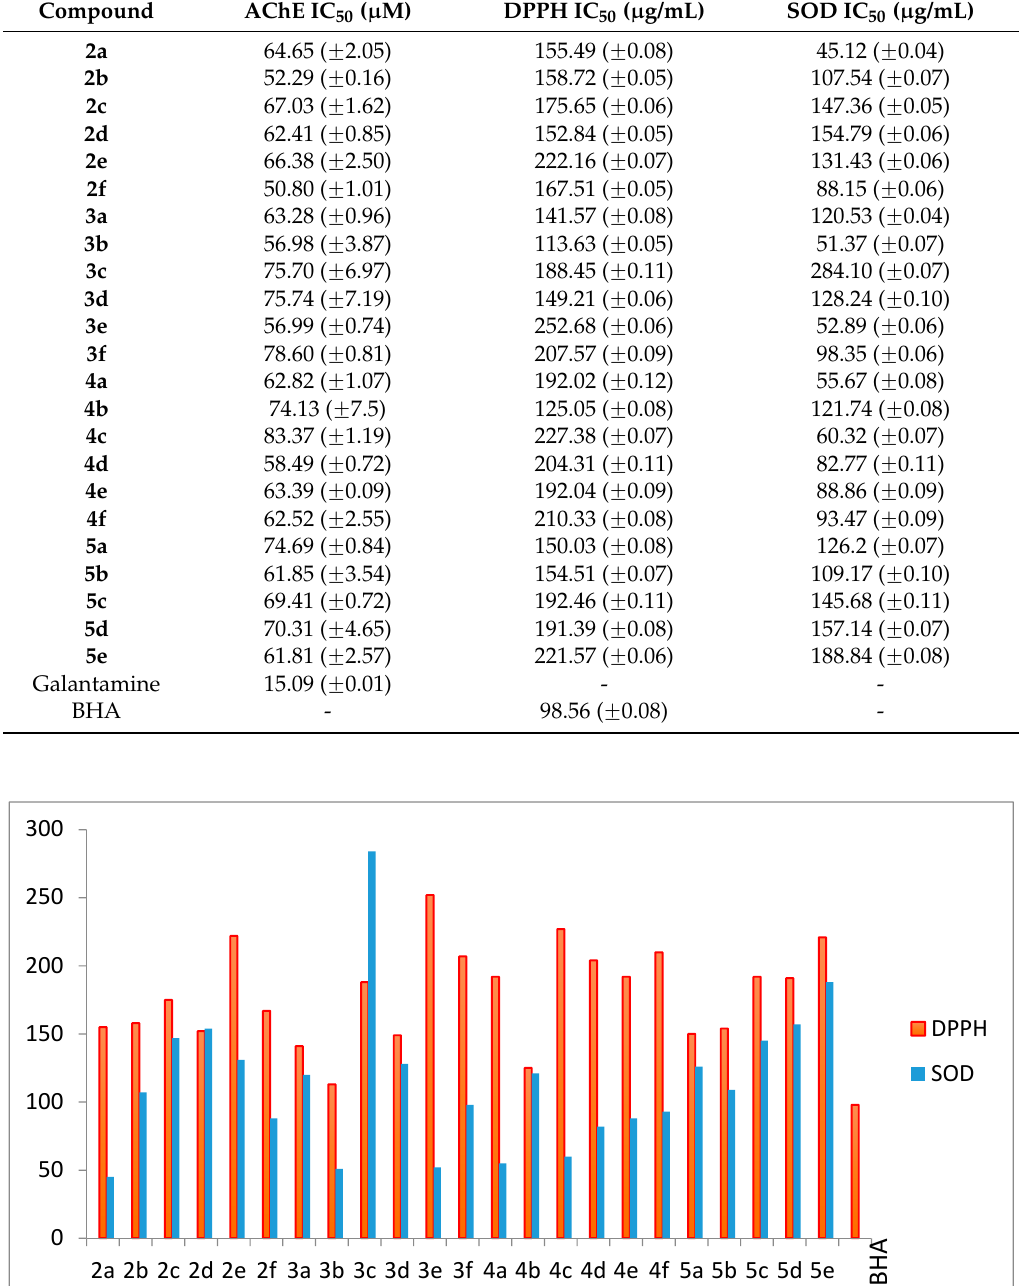
Table 1. IC 50 values of the 1,2,3-triazole compounds 2 – 5 ( a – f ) for AChE inhibition, DPPH and SOD activities.